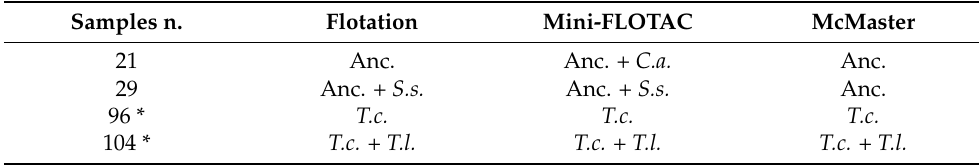
Table 10. Species detected by each technique in co-infected cats. Samples n.